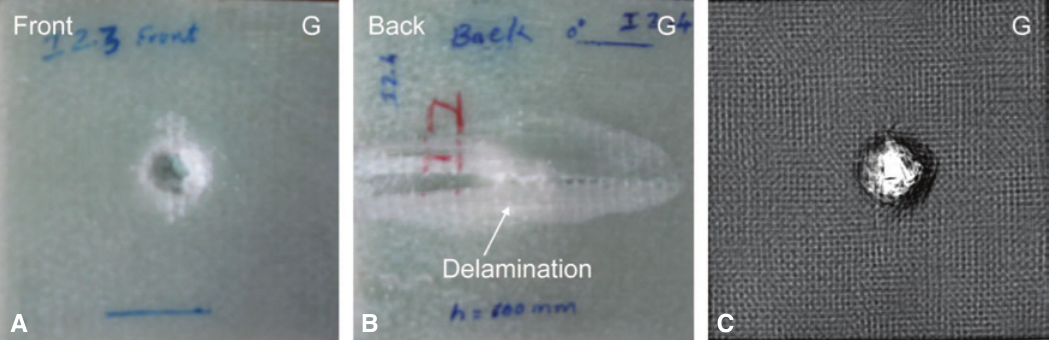
Figure 4: Photographs of impacted specimen